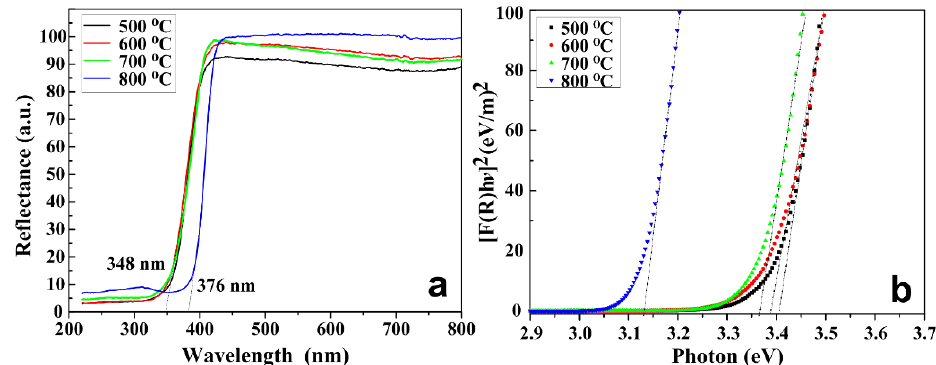
Figure 6. ( a ) UV-Vis reflectance spectrum of TiO 2 nanoparticles; ( b ) plot of the square of the Kubelka–Munk function vs. photon energy for calcined samples at different temperatures.